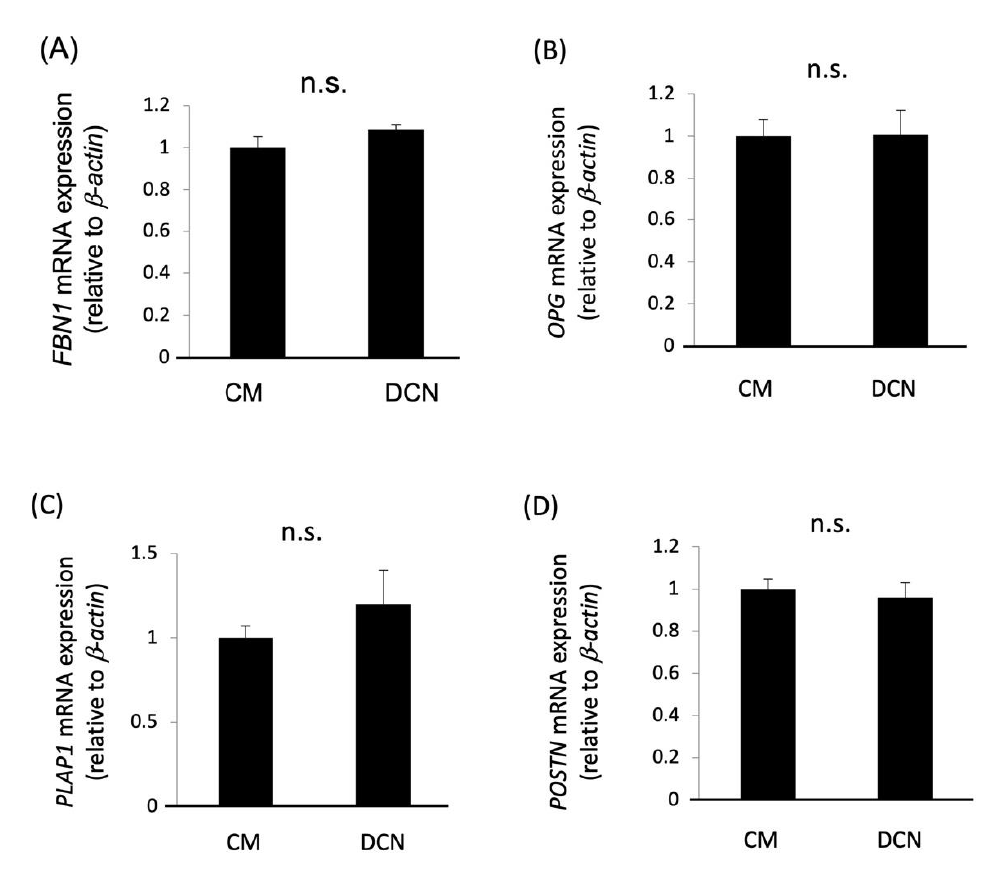
Figure 6. Effects of DCN on the expression of PDL-related genes in HPDLSCs. ( A – D ) Quantitative RT-PCR was performed to analyze the gene expression of FBN1 ( A ), OPG ( B ), PLAP1 ( C ), and POSTN ( D ) in HPDLSCs cultured in 10% FBS/ α -MEM (CM) or CM on a 2 µ g/mL DCN coating (DCN) for 7 days. Values are the mean ± SD of three indepenDent. experiments. n.s. = no signifi- cance.